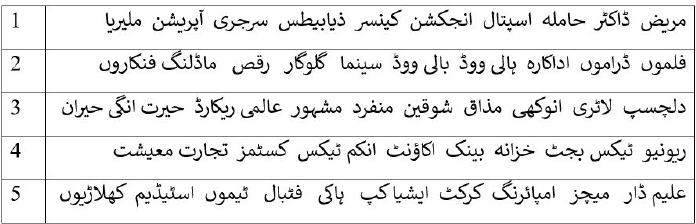
Figure 5. First ten words of seeded topic of each